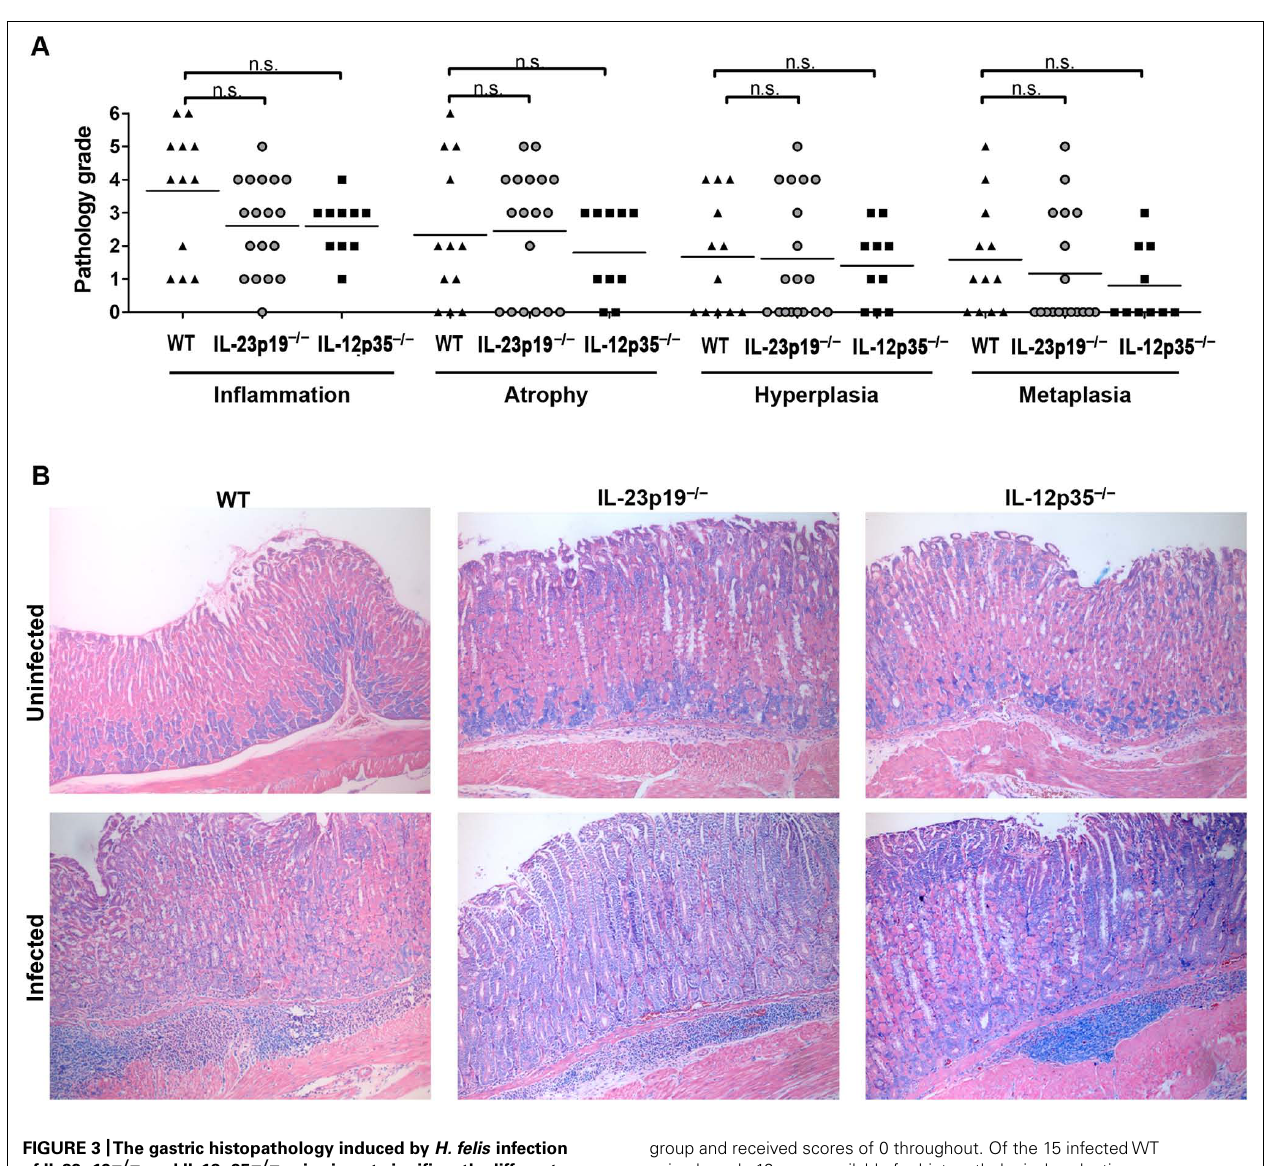
FIGURE 3 |The gastric histopathology induced by H. felis infection of IL-23p19 − / − and IL-12p35 − / − mice is not significantly different from that of wild type animals. (A) Histopathology scores assigned to every mouse shown in Figure 2 for all indicated parameters on a scale of 0–6. Note that five uninfected controls were examined per